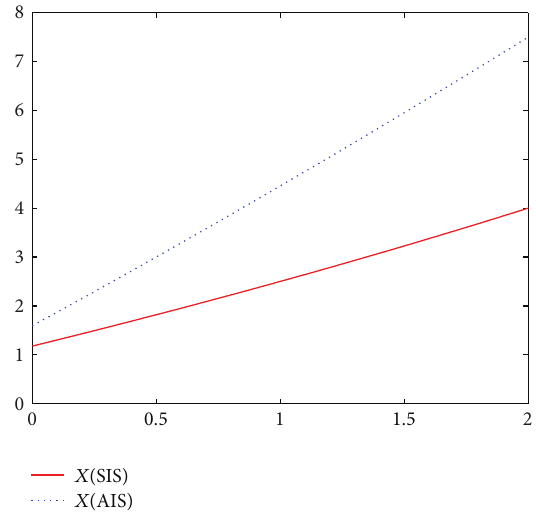
Figure 10: Total R&D inputs with innovation